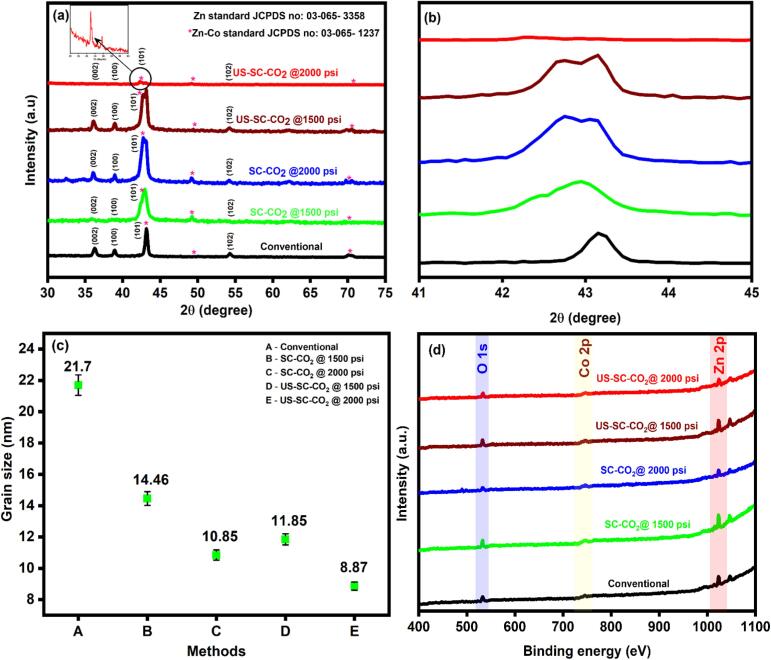
(a) XRD profile quantitative analysis spectrum, (b) magnified portion of main diffracted peak, (c) calculated grain size, (d) XPS survey spectrum fabricated films.